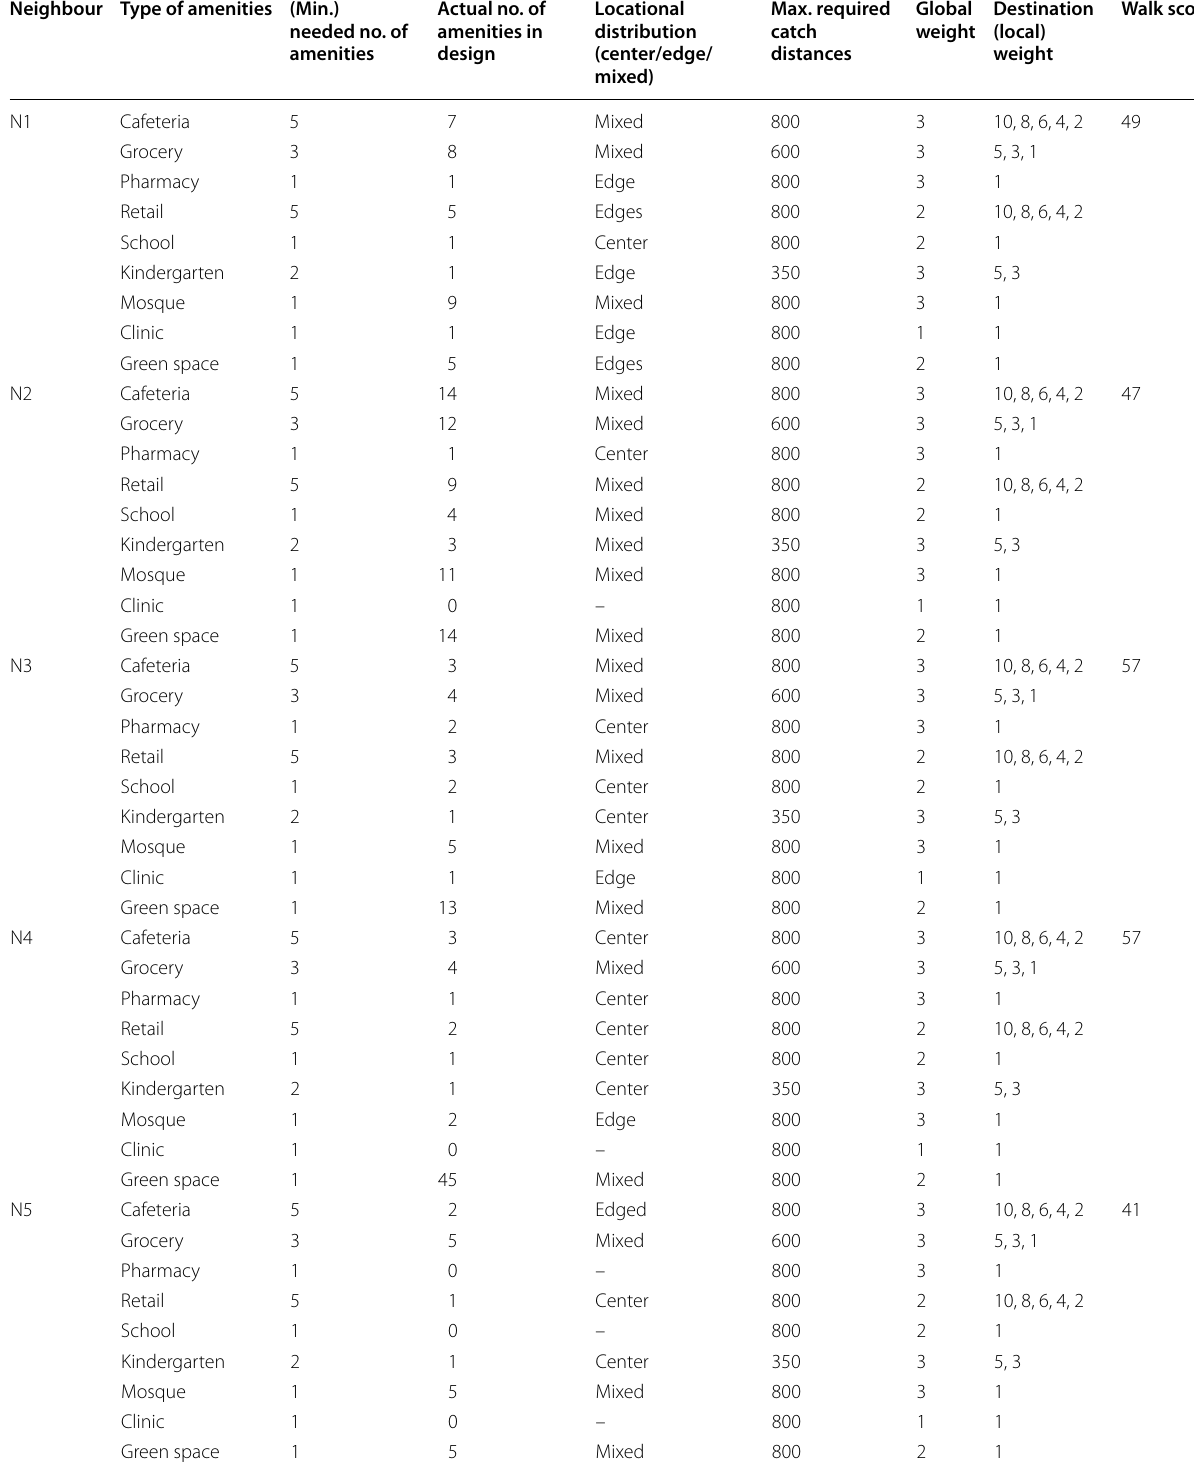
Table 6 Macroscale urban planning measures and the resulting UMI Walkscore Neighbour Type of amenities (Min.) needed no.